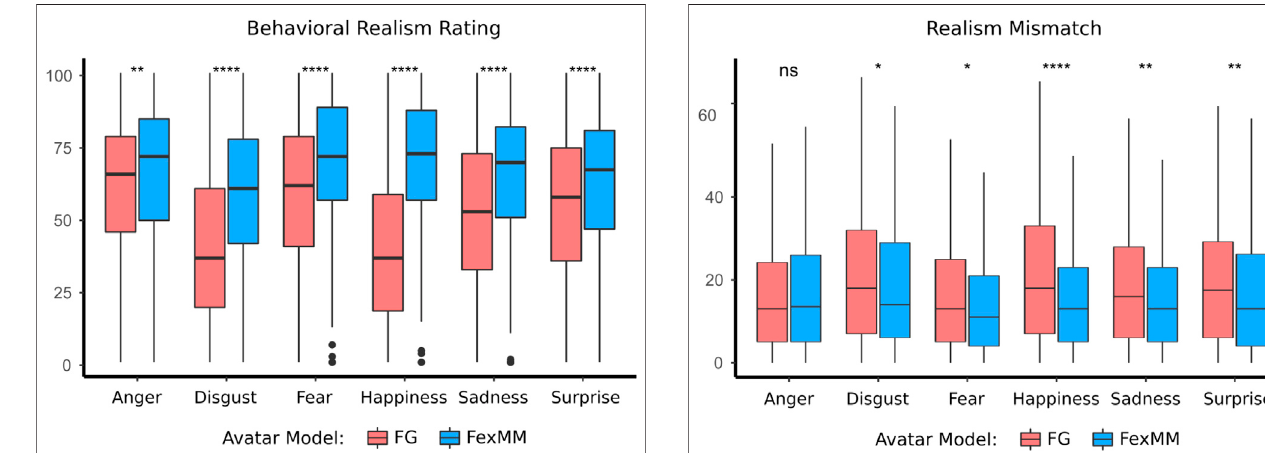
FIGURE 11 | Boxplot of realism mismatch computed as absolute differences between the single ratings. The boxes denote the interquartile range and the median. Level of signi fi cance is indicated by * ( p < 0 . 05 ) , ** ( p < 0 . 01 ) , and **** ( p < 0 . 001 )